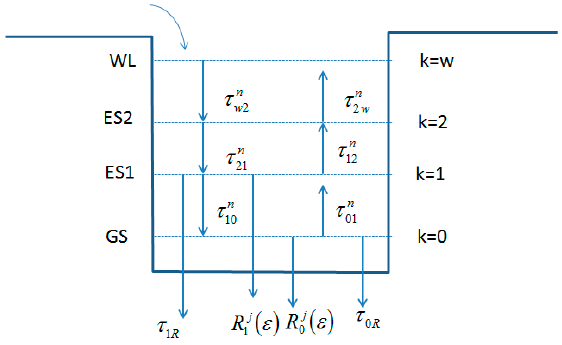
Figure 2. Energy-band diagram of the conduction band of the device.